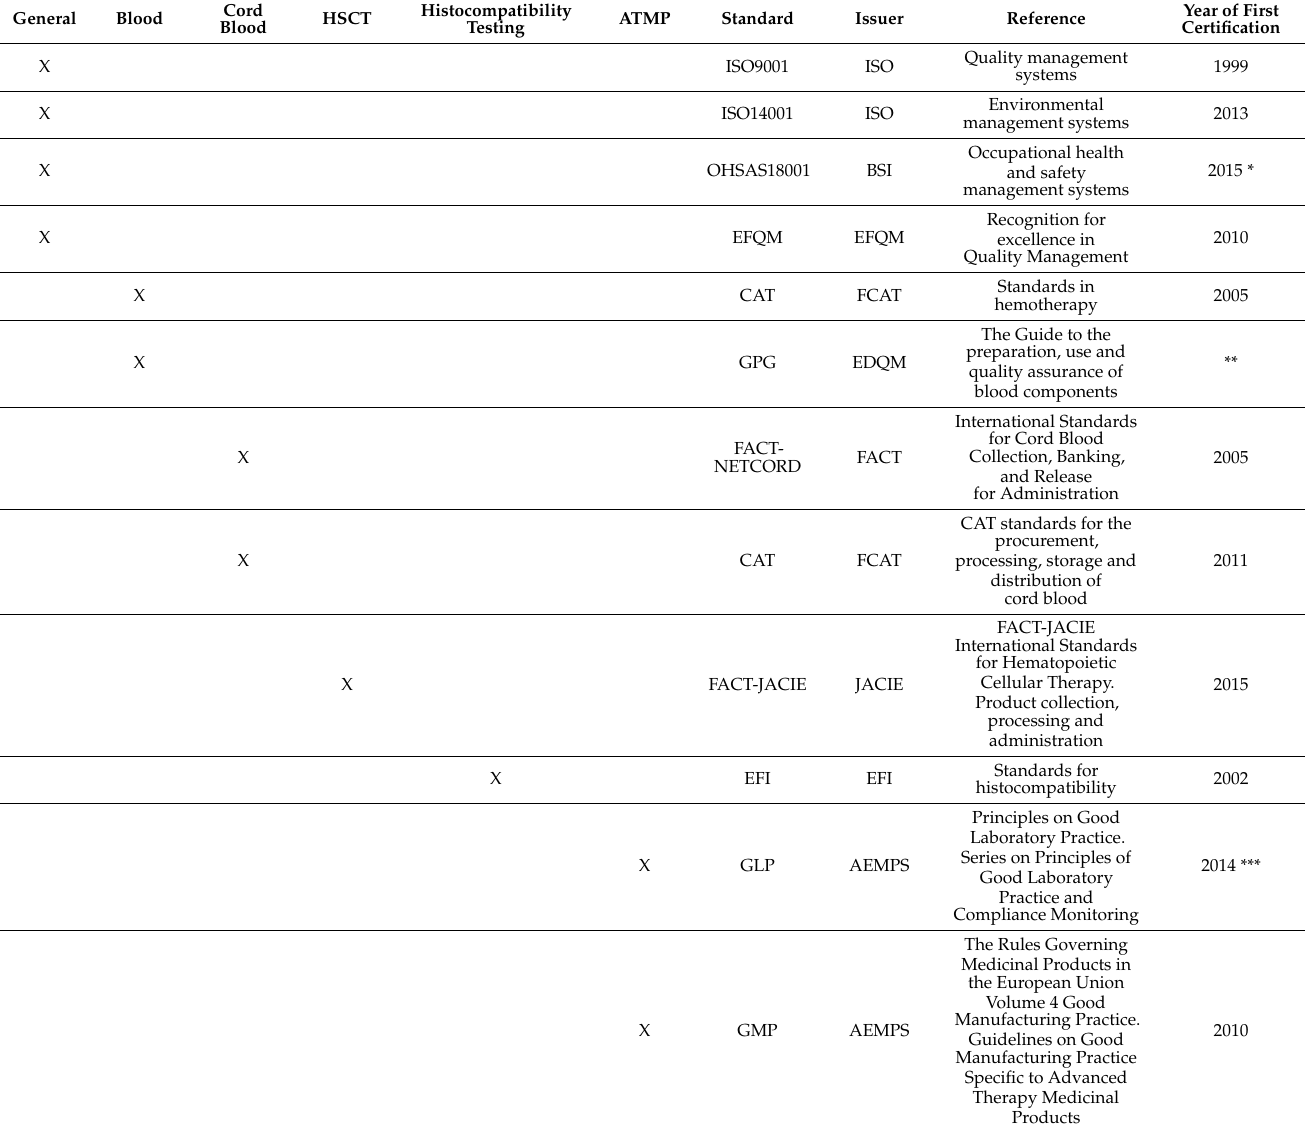
Table 2. Quality ecosystem at Banc de Sang i